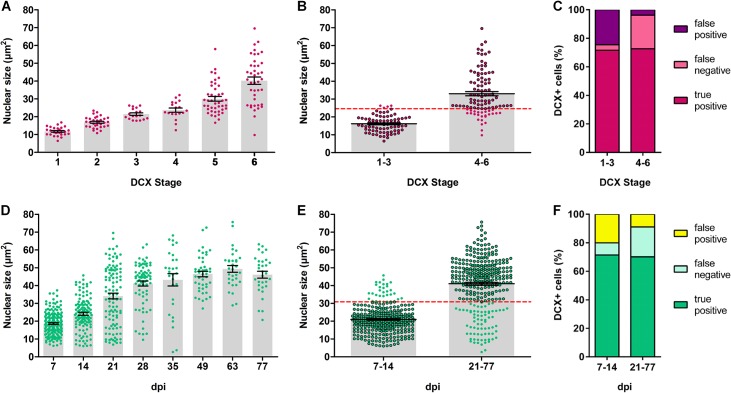
Nuclear size measurement as a valuable tool to discriminate between early and late stages in structural maturation and age of newborn DGCs.(A, D) The correlation of nuclear size with structural stage and cell age is illustrated as a dot plot (each dot represents a single cell, pooled from all animals per group) to highlight the variability. (B, E) Newborn DGCs were pooled in an early (DCX stage 1–3, cell age 7–14 dpi) and a late phase (DCX stage 4–6, cell age 21–77 dpi). The mean nuclear sizes of each group were determined and used to calculate the equidistance between early and late phases, which was then used as a threshold to discriminate and assign newborn DGCs to the early or the late phase of development (shown as red dashed line). (C, F). Based on that threshold, cells were categorized into true positive, false positive and false negative predictive values. True positive classifications were found with a reliability of about 70% across all stages. Number of animals: (A, D) DCX stage 1: n = 5, stage 2: n = 7, stage 3: n = 4, stage 4: n = 6, stage 5: n = 9, stage 6: n = 11; cell age: n = 3 per group. (B, E) DCX stage 1–3: n = 8, stage 4–6: n = 12; cell age 7–14 dpi: n = 6, age 21–77 dpi: n = 18. Error bars represent SEM.